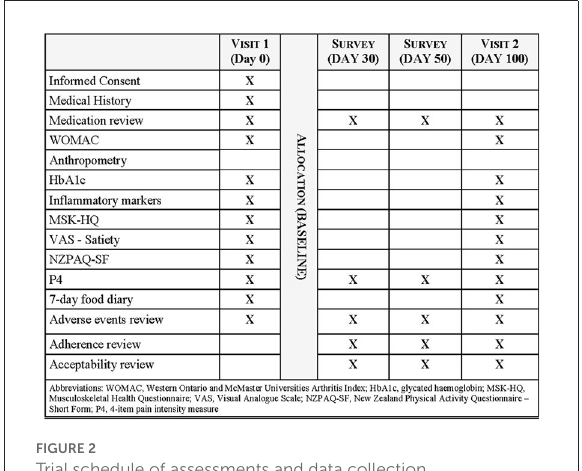
FIGURE2 Trial schedule of assessments and data